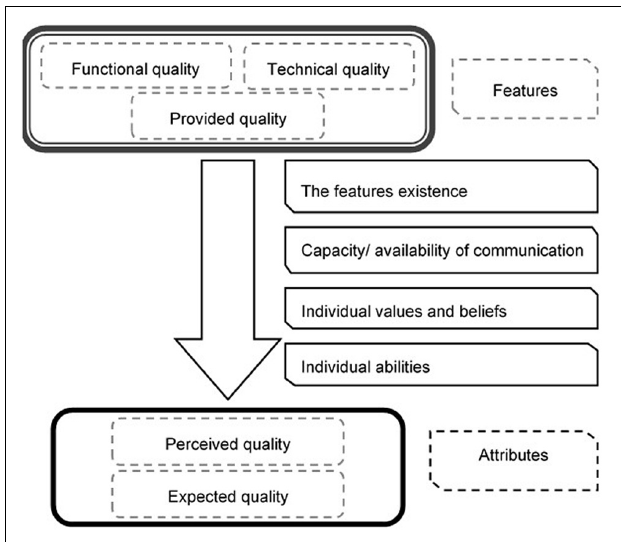
FIGURE 1 | The relation between quality in terms of food safety, attributes, and features. Source: